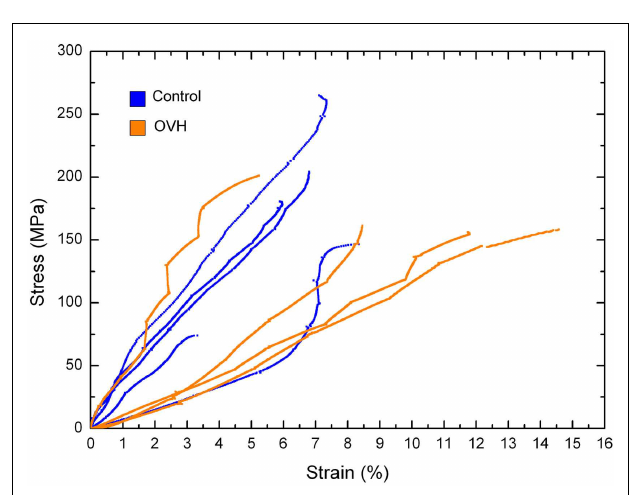
average elastic modulus values in our micro-beam compression show larger variations between osteoporotic and healthy bone samples than the results in Table 1 , highlighting the sensitiv-